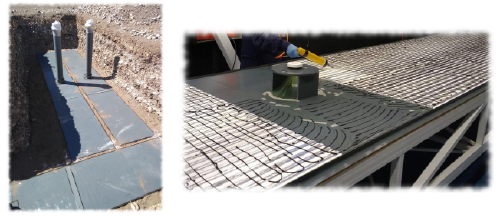
Figure 3. (Left) Three modules of 10 m 2 deployed in the field. (Right) Scintillator module constructed in the assembly building.